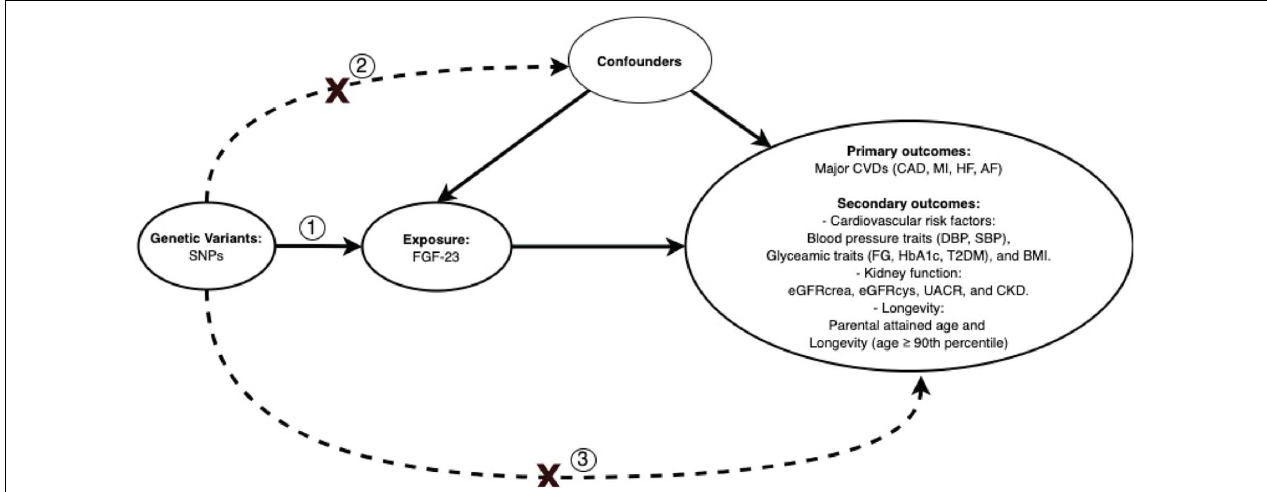
FIGURE 1 | Directed acyclic graph illustrating Mendelian randomization assumptions. Three assumptions should be satisfied: (1) the genetic variants, i.e., SNPs, should predict FGF23; (2) the SNPs should not be associated with potential confounders; (3) the SNPs should only affect the outcomes through affecting FGF23. SNPs, single nucleotide polymorphisms; CAD, coronary artery disease; MI, myocardial infarction; HF, heart failure; AF, atrial fibrillation; SBP, systolic blood pressure; DBP, diastolic blood pressure; FG, fasting glucose; HbA 1 c , glycated hemoglobin; T2DM, type 2 diabetes mellitus; BMI, body mass index; eGFRcrea, estimated glomerular filtration rate from creatinine; eGFRcys, estimated glomerular filtration rate from cystatin C; UACR, urinary albumin-to-creatinine ratio; CKD, chronic kidney